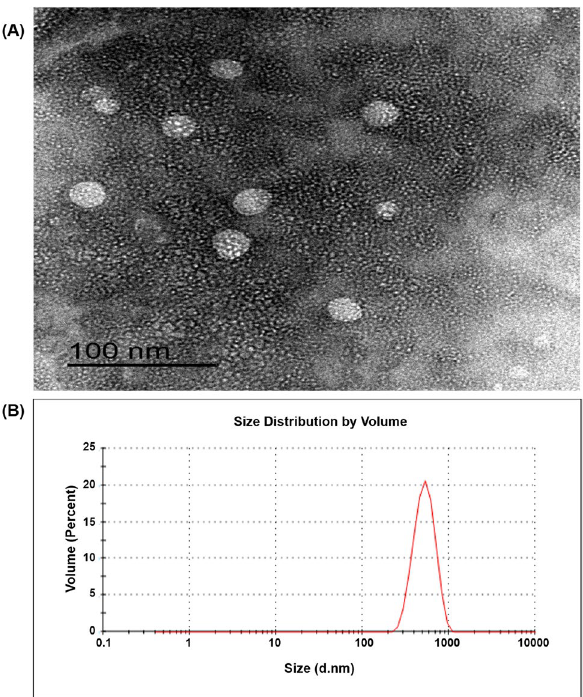
Figure 5. ( A ) TEM image of ALL-loaded CS/STPP NPs (F-9). The image was captured using Gatan Microscopy Suite Software, version 2.11.1404.0, (http://www.gatan .com/produ cts/tem-analy sis/gatan -micro scopy -suite -softw are). ( B ) size distribution curve of ALL-loaded CS/STPP NPs